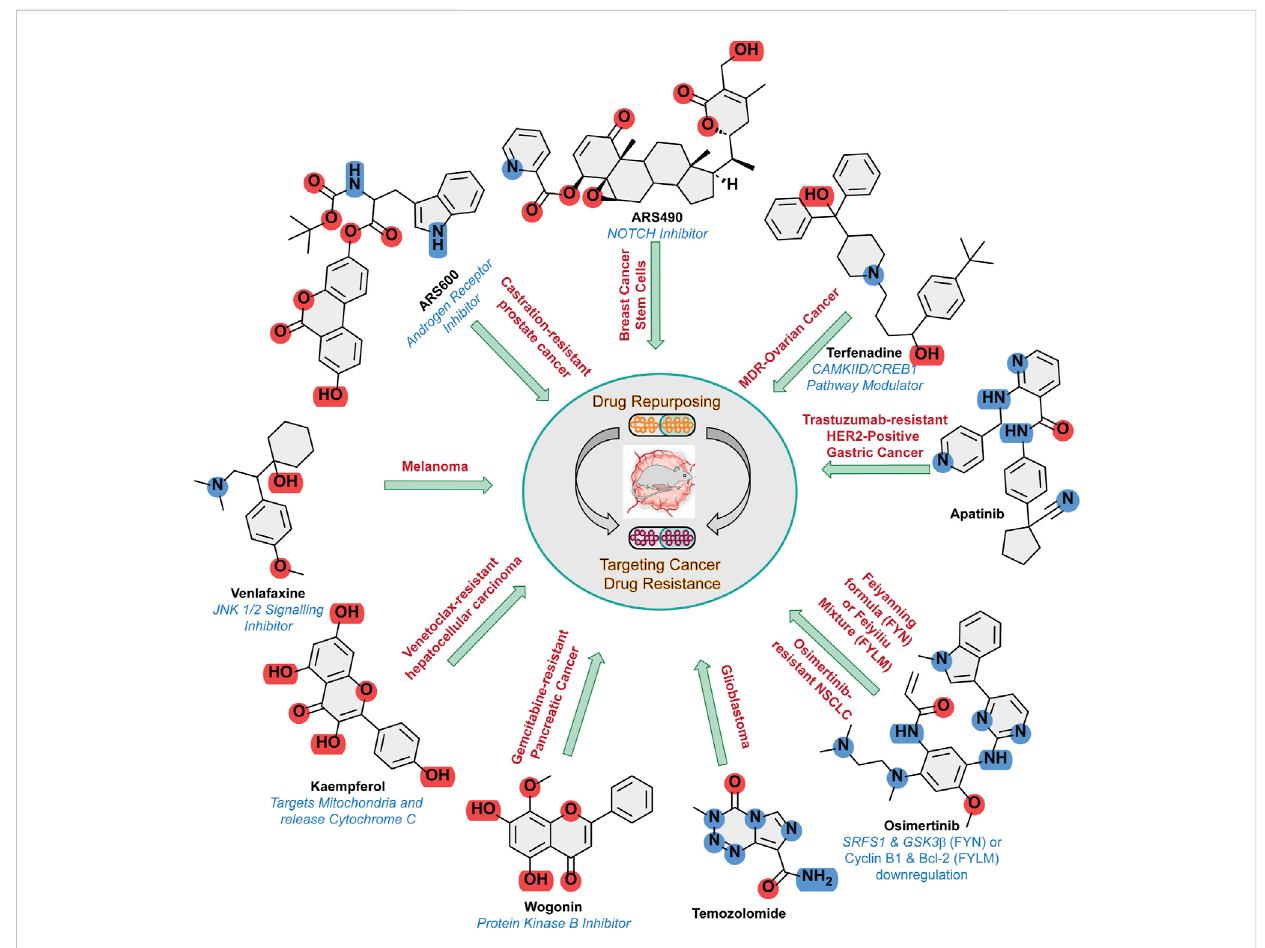
FIGURE 1 Summary of repurposed small molecules and their mechanism of actions to tackle drug resistance in the panel of cancers mentioned.